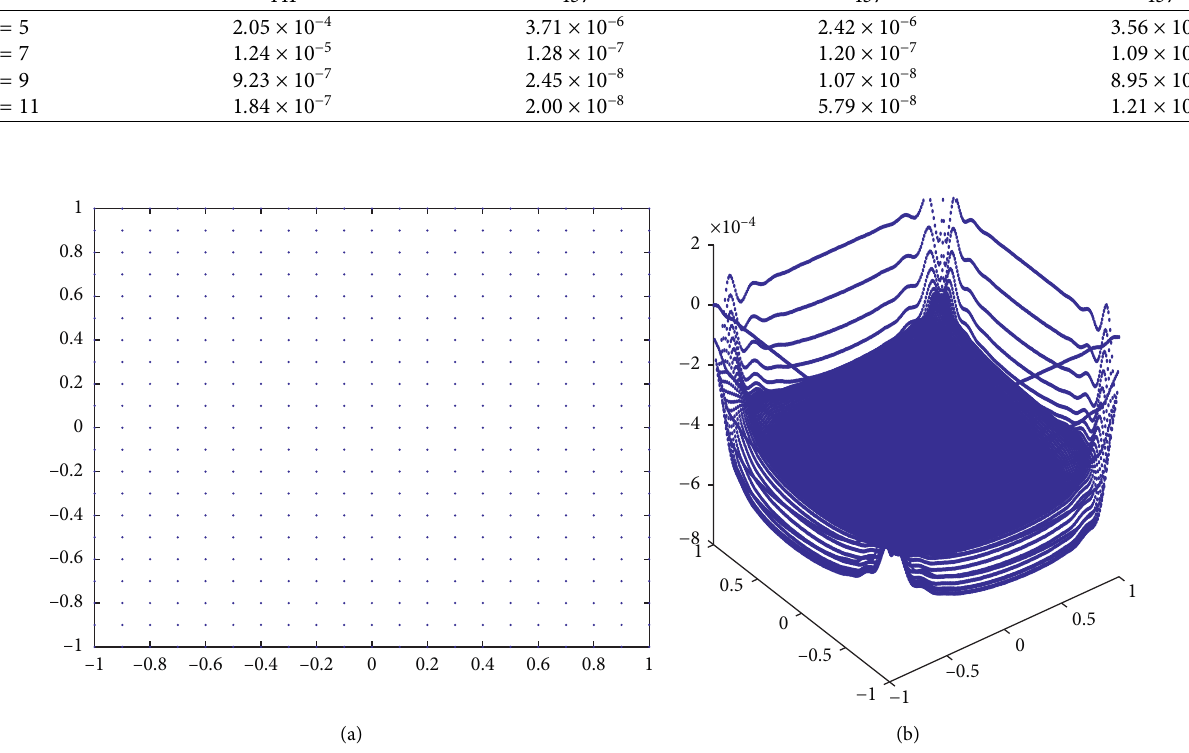
Figure 1: Configuration of the source points (a) and the corresponding absolute errors (b) for the traditional CRBF.